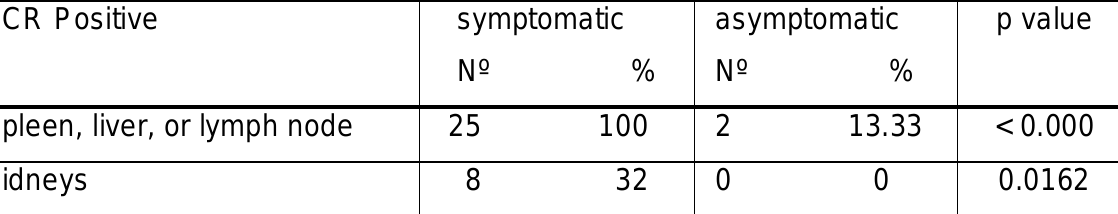
Table 1. PCR of symptomatic (n=25) and asymptomatic (n=15) VL-seropositive dogs from Teresina, Piauí State, Brazil, 2002.